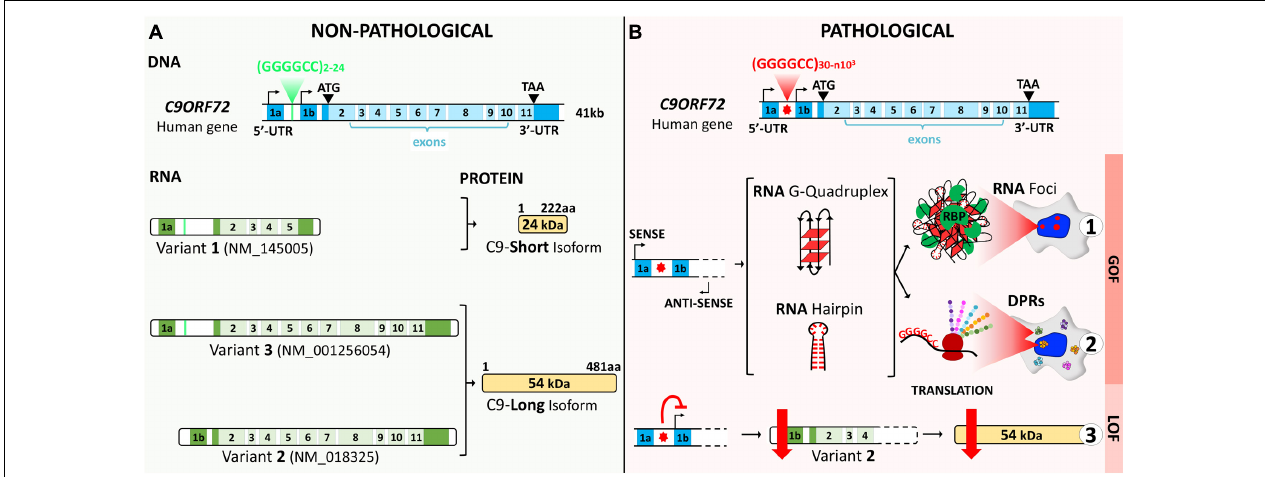
FIGURE 1 | C9ORF72 gene structure, transcript variants, and protein isoforms under a non-pathological (A) and a pathological (B) state. (A) The C9ORF72 human locus includes two non-coding exons (1a and 1b) and 10 coding exons (from 2 to 11). It gives rise to three coding variants: variant 1, V1 , which includes exon 1a and exons 2–5; variant 2, V2 , which includes exon 1b and exons 2–11; and variant 3, V3 , which includes exon 1a and exons 2–11. Alternative splicing of these three RNA variants results in the production of two different isoforms: the 222-amino acid (aa) isoform (C9-short of 24 kDa) encoded by V1 and the 481-aa isoform (C9-long of 54 kDa) encoded by V2 and V3. The coding exons are indicated in light blue and the non-coding exons in dark blue . (B) In a pathological state, the G 4 C 2 repeat localized between the two non-coding exons (1a and 1b) is abnormally expanded and results in three possible pathogenic mechanisms. Bidirectional transcription of the hexanucleotide repeat expansion (HRE) generates G 4 C 2 sense and G 2 C 4 antisense expanded RNAs. These HRE transcripts give rise to G-quadruplex and hairpin structures that can form RNA foci and sequester RNA-binding proteins ( RBP ) ( B1 ). Expanded RNAs are also translated through repeat-associated non-ATG ( RAN ) translation, resulting in the synthesis of dipeptide protein repeats ( DPRs ) ( B2 ). Finally, the presence of the HRE inhibits transcription, leading to a decrease in the C9ORF72 protein ( B3 ).